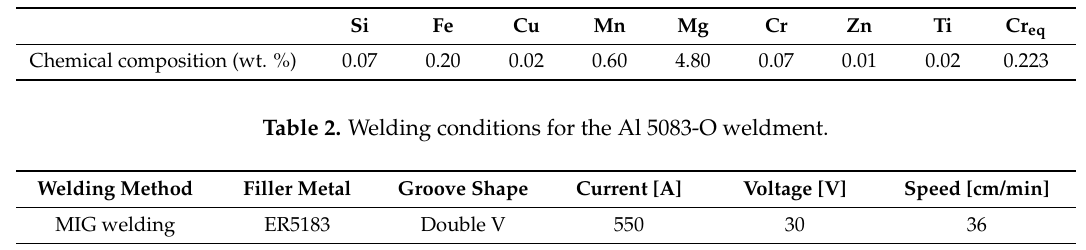
Table 1. Chemical composition of Al 5083-O.